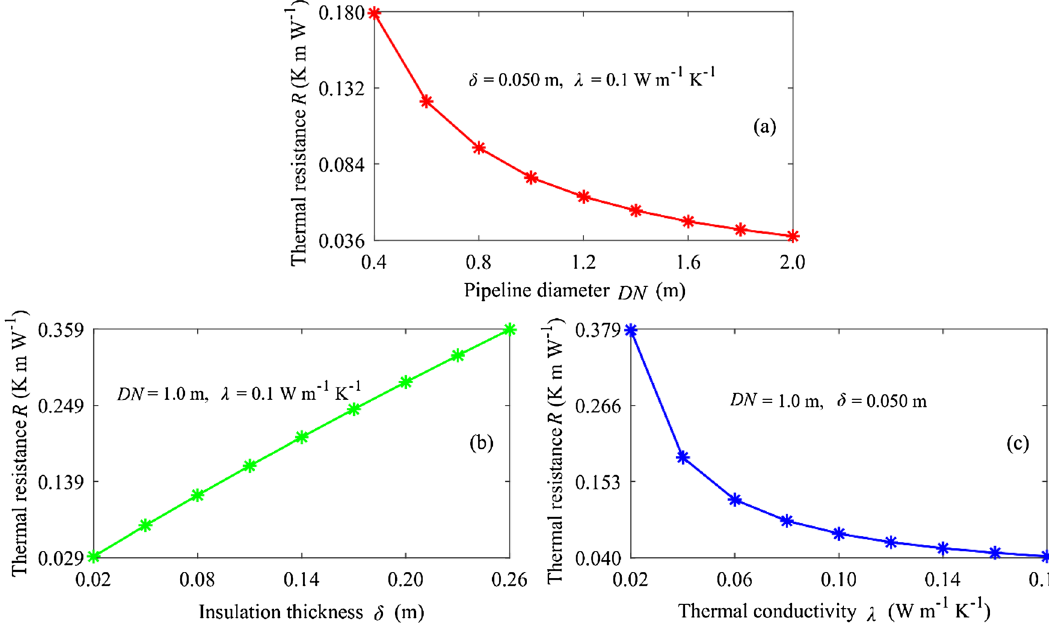
Fig. 2 Heat transport pipeline thermal